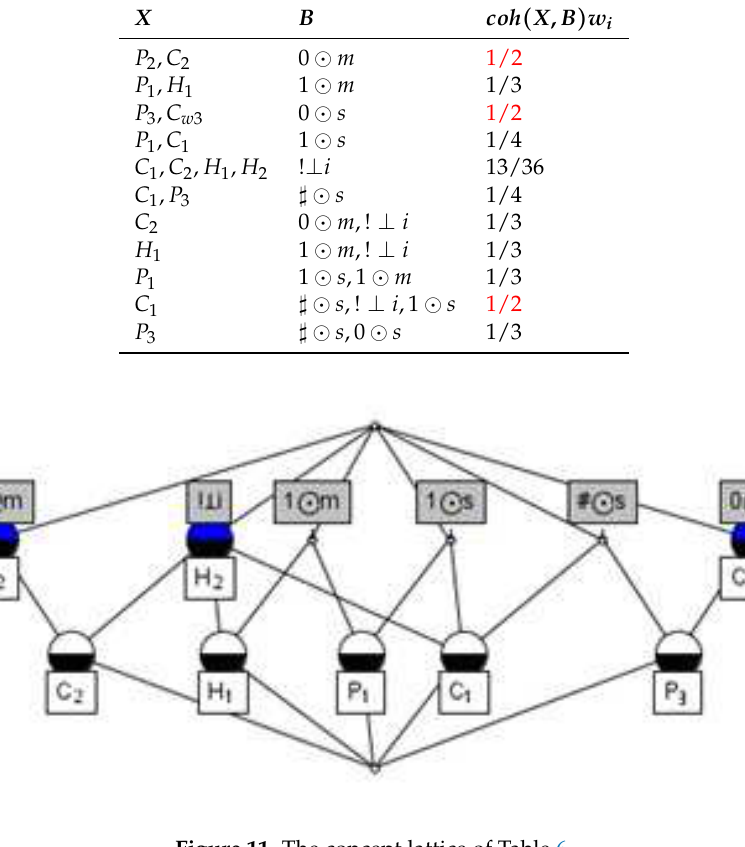
Figure 11. The concept lattice of Table